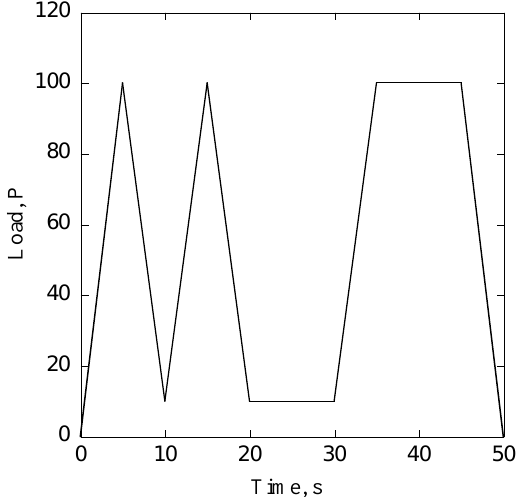
Figure 2. Typical load–time sequence used for load–partial unloading